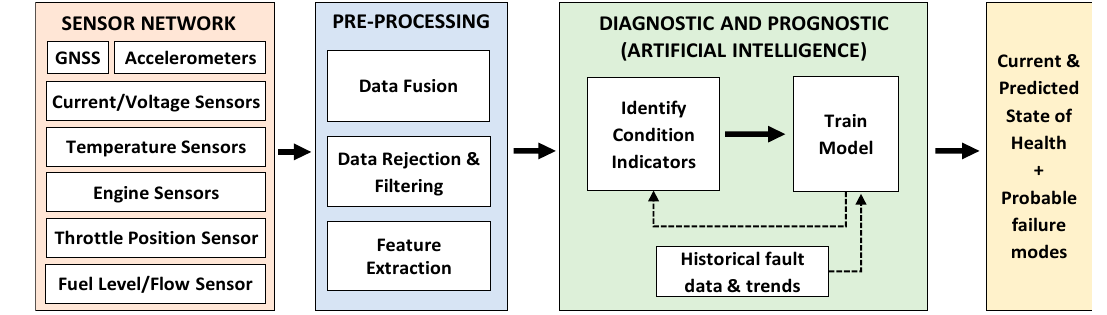
Figure 1. Health and usage monitoring system (HUMS) data workflow diagram.